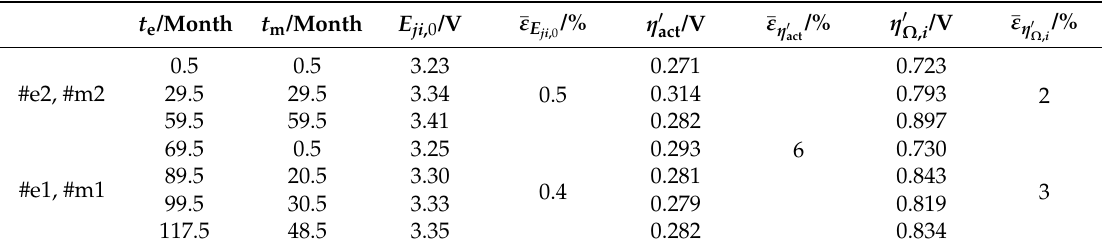
Table 2. Relative error between the actual values of E ji ,0 , η Ω ,I (cid:48) and η act (cid:48) and the corresponding linear regression, for the first and second stages of the data